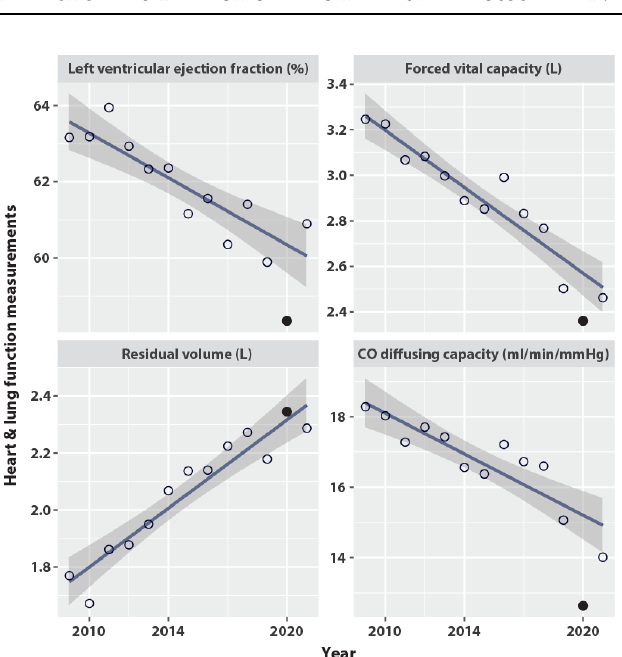
Figure 3. The effect by year on heart and lung function. Open circle: value of the function averaged on all patients observed in the year. Filled circle: value observed in 2020, year of the COVID pandemic. Line: ordinary least squares fitted on years 2009 – 2021 excluding 2020. Grey band: 95% confidence interval of the least squares fit. The slopes per year are: Left ventricular ejection fraction (%) − 0.29; Forced vital capacity (L) – 0.063 (=63 mL); Residual volume (L) +0.052 (=52 mL); carbon-monoxide (CO) diffusing capacity (ml/min/mmHg) – 0.29.